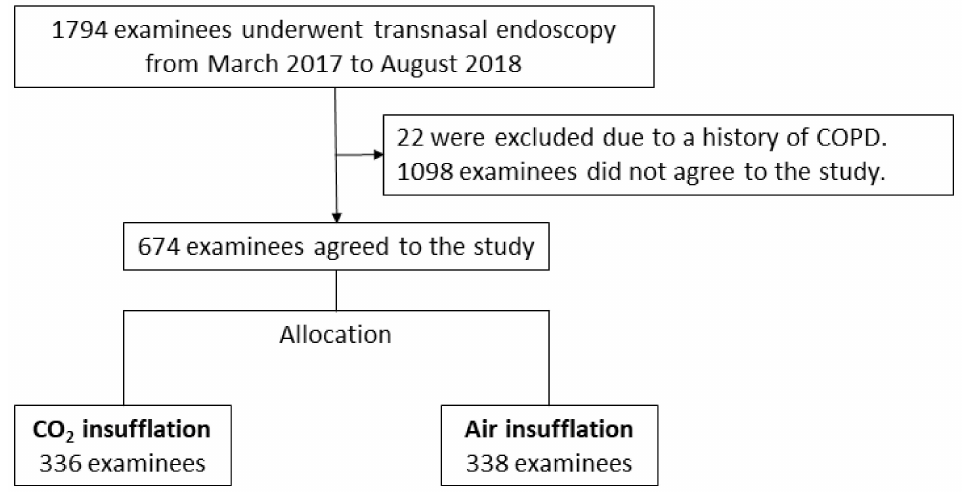
Figure 1. Flow chart of examinee allocation. Of the total 1794 examinees, 674 were finally included in the analysis.